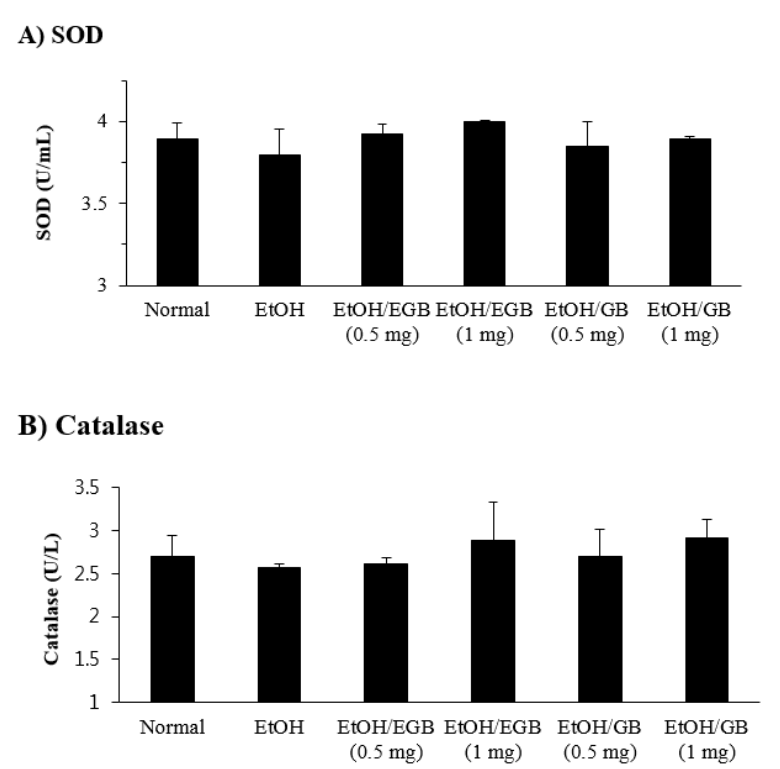
Figure 5. Effect of EGB on the level of antioxidant enzymes in liver tissues in AILD. The SOD ( A ) and catalase ( B ) levels were measured using the liver tissues collected 1 day after the final administration of EtOH.